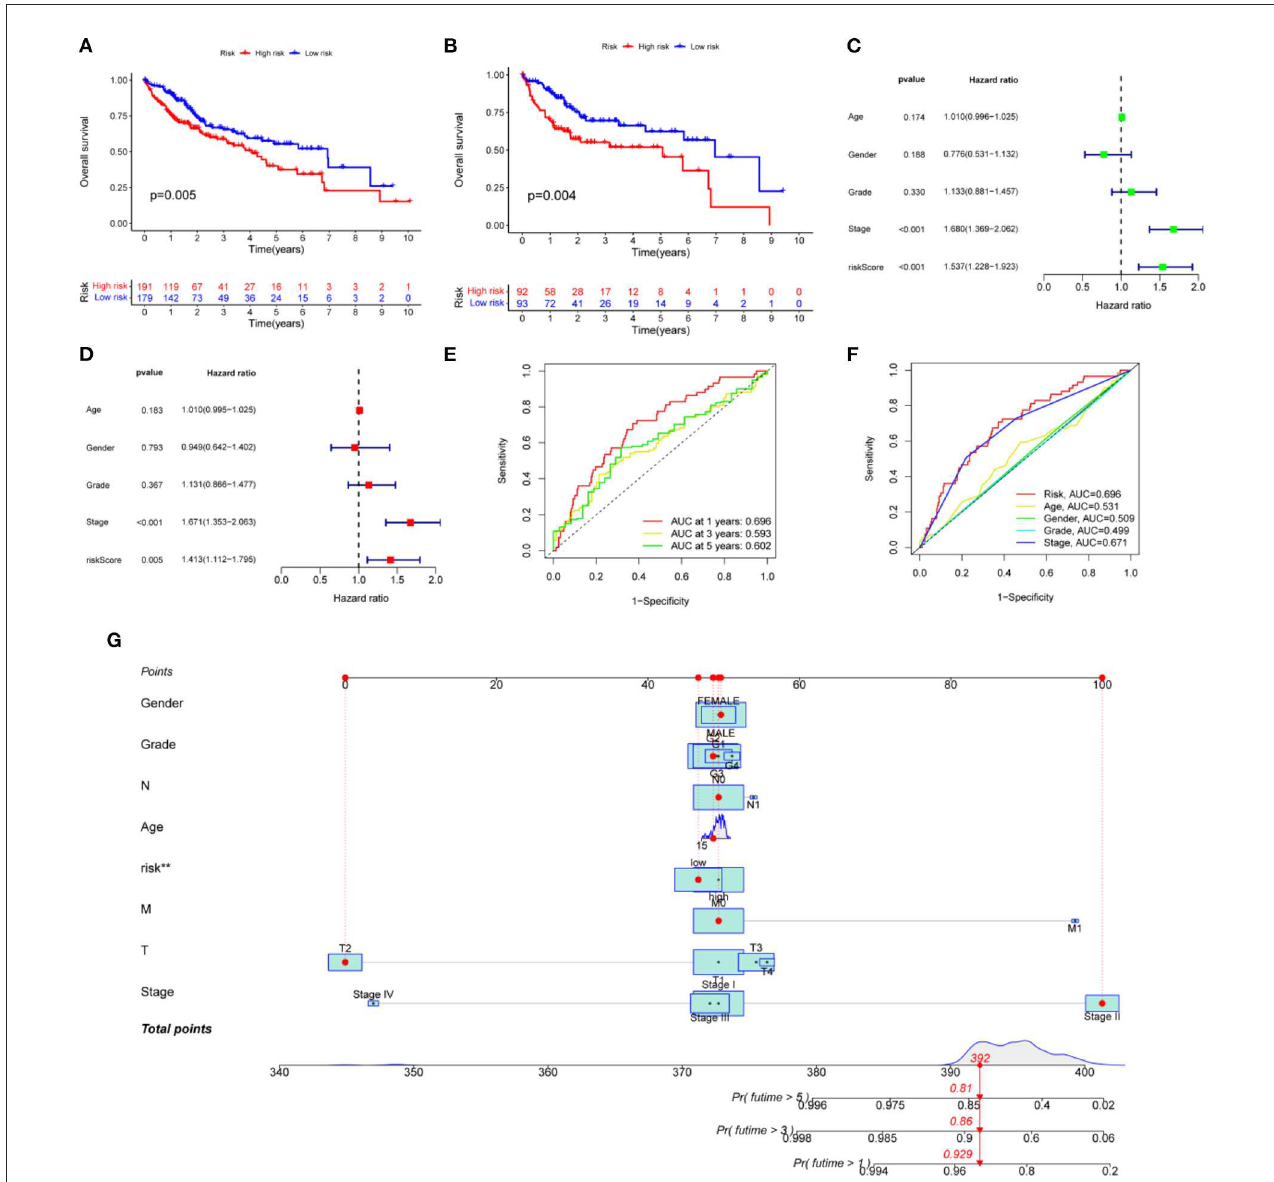
FIGURE5 Developing a prognosis model for HCC. (A) Prognostic curves for the overall sample group; (B) The survival prognosis curve for the training group; (C) Analysis of independent prognostic factors based on single-factor regression; (D) Analysis of independent prognostic factors based on multi-factor regression; (E) HCC 5-year survival ROC curves; (F) HCC risk factor ROC curves; (G) Nomograph of metabolomic prognostic models for